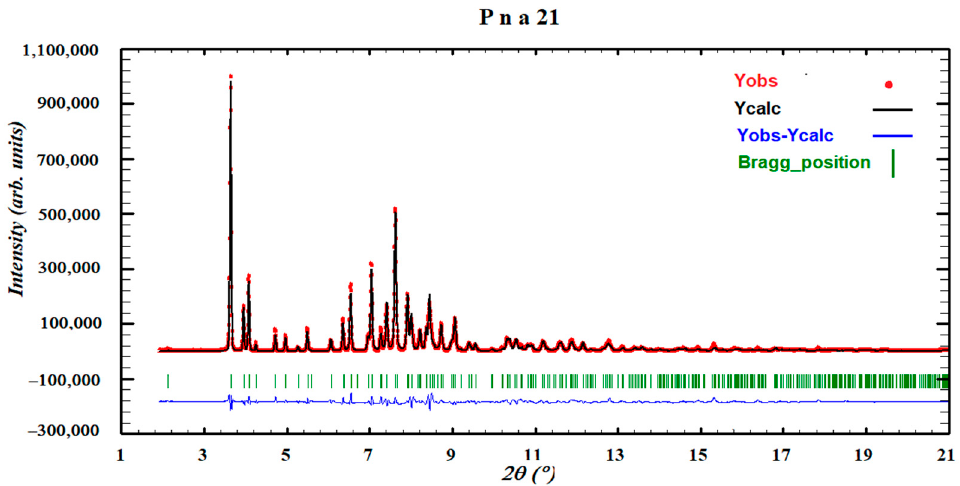
Figure 20. Final Rietveld plot for the crystal structure refinement of form S CHCl3-H2O . Agreement factor: Rwp = 2.3%. The plot shows the experimental powder XRD profile (red+marks), the calculated powder XRD profile (black solid line) and the difference profile (blue, lower line). Tick marks indicate peak positions